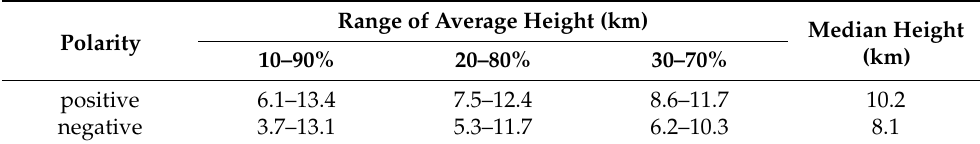
Table 2. The average height of IC events on 16 May